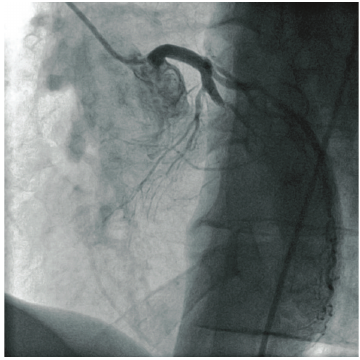
Figure 2: Left coronary artery (RAO 31, caudal 0,4).